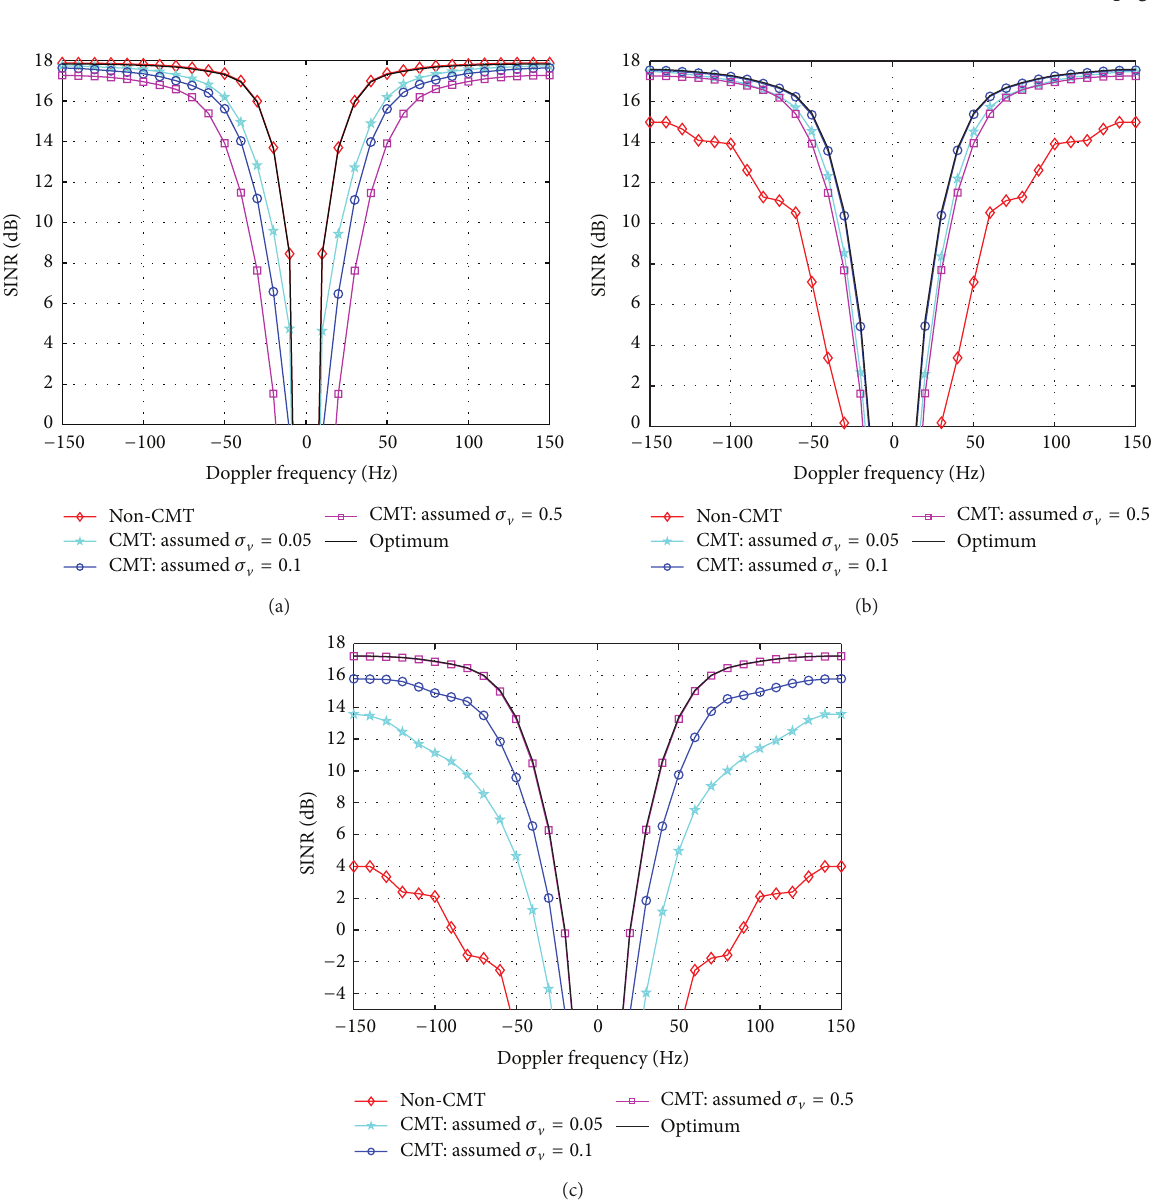
Figure 3: Impacts of ICM on SINR performance against Doppler frequency with 4 snapshots and the target Doppler frequency space from 𝜎 𝜎 − 150 to 150 Hz. (a) 𝜎 V = 0; (b) V = 0.1; (c) V =